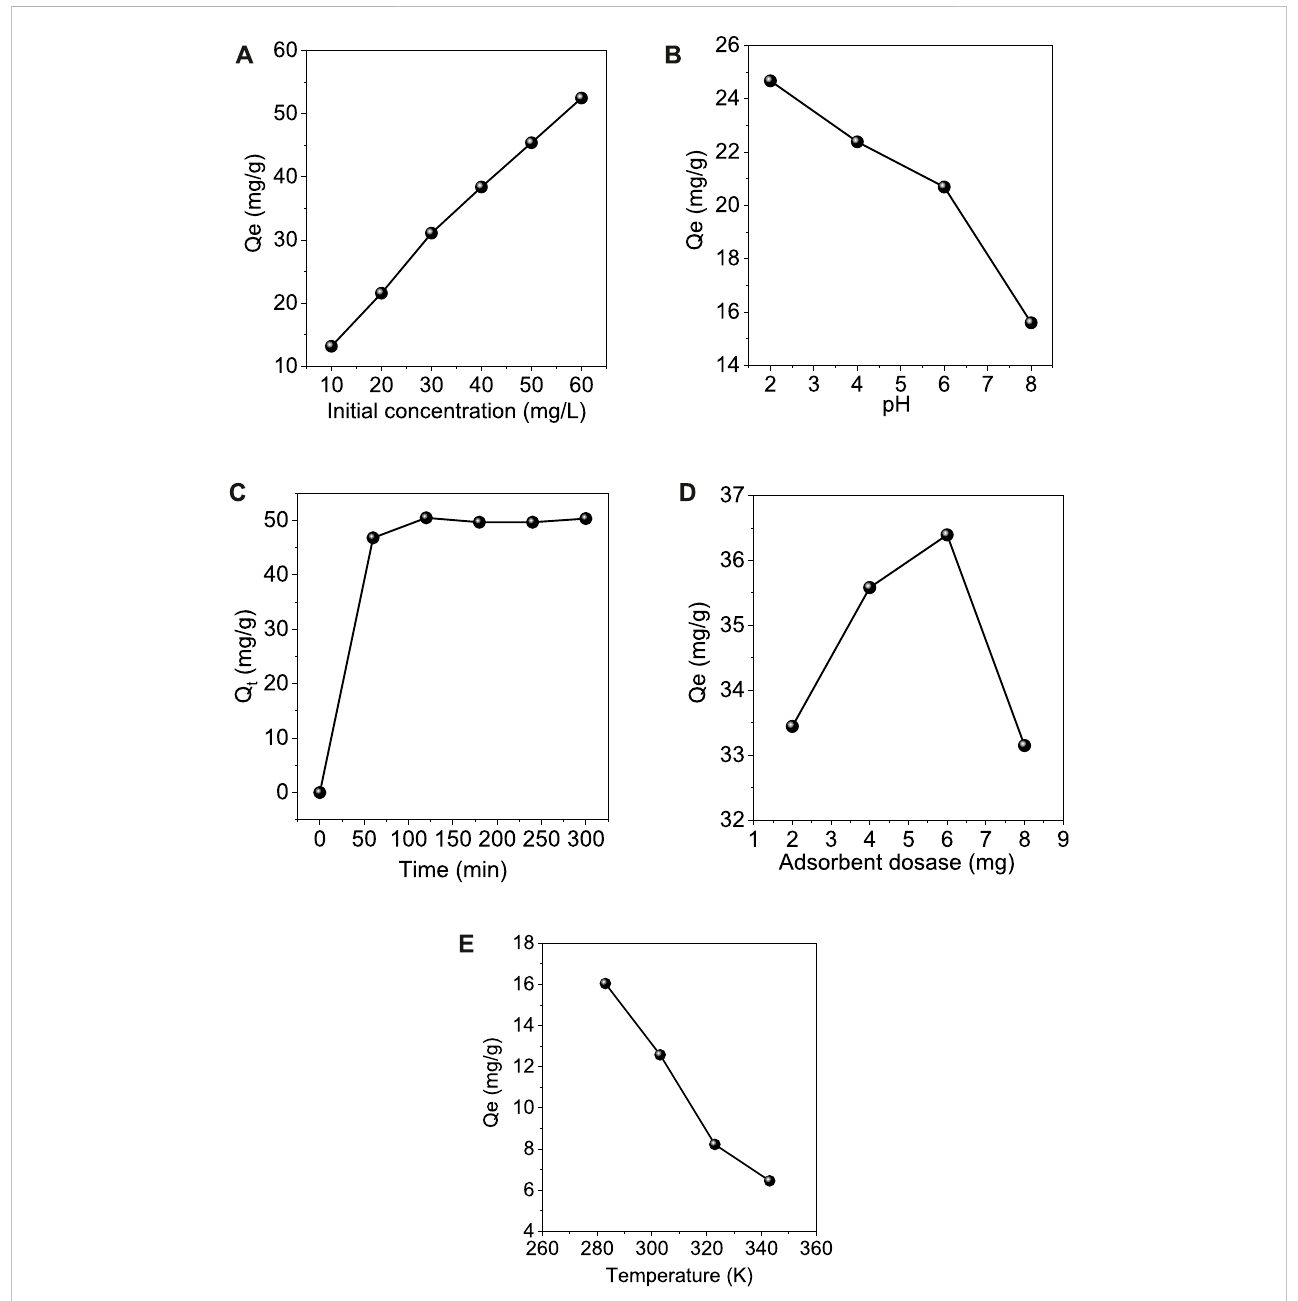
FIGURE 7 Effect ofdifferent optimization parameters on theadsorption of Cr (VI) onto GO/ZM nanocomposite (A) Initial concentration (B) pH (C) Contact time (D) Adsorbent dosage (E) Temperature.